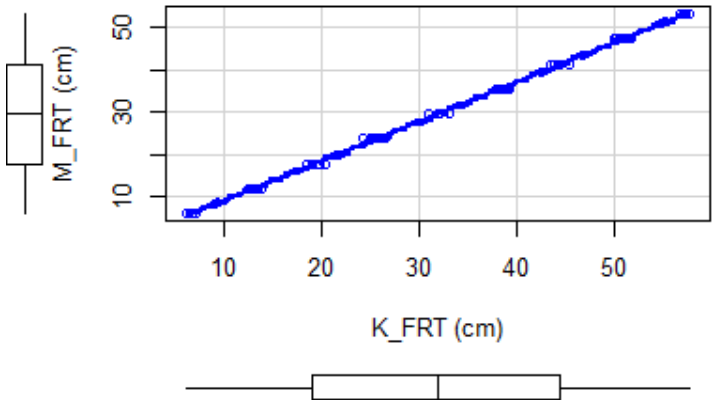
Figure 14. Scatter plot of the data obtained by the experimental system and manually in Experiment 2. Finally, in Figure 16, a Bland–Altman plot is shown for experiment 2. The agreement between the two methods is also remarkable because there is no much difference between limits of agreement ( ≈± 1.1 units). Moreover, the mean differences is − 0.0619, which means that there is also no bias.